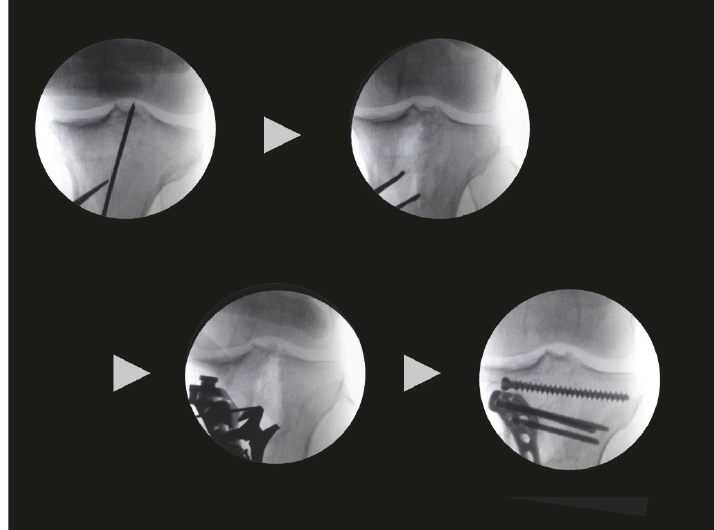
Figure 7: Tibial condylar valgus osteotomy